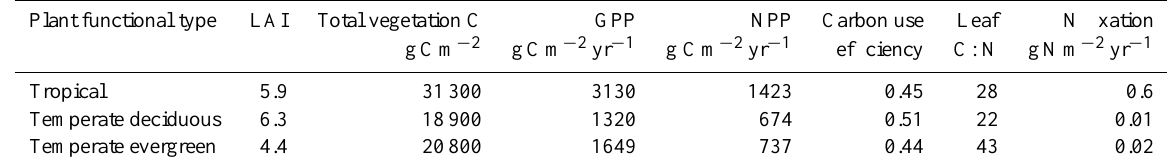
Table 7. Steady state values of key ecosystem parameters for the three test systems evaluated with ACONITE. Plant functional